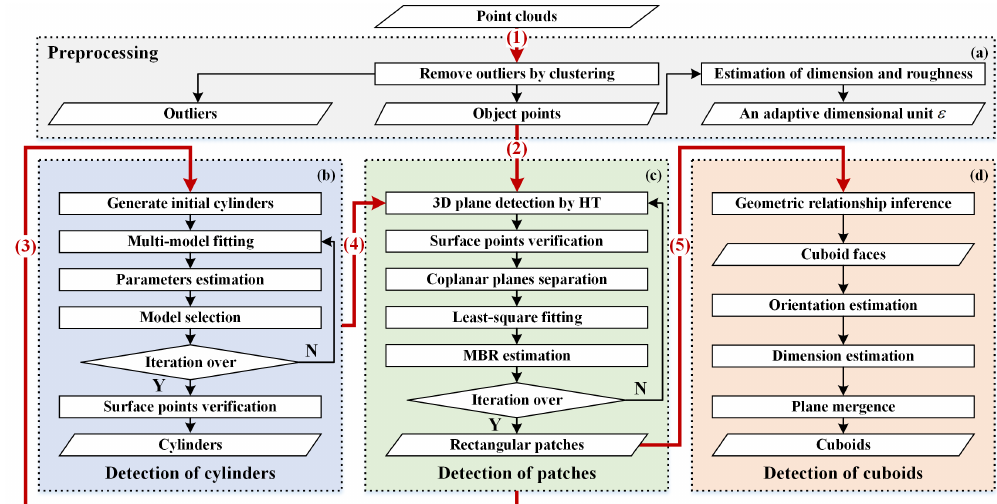
Figure 1. Procedure of the proposed spacecraft component detection scheme. The scheme consists of four modules: ( a ) preprocessing; ( b ) detection of cylinders; ( c ) detection of planar patches and ( d ) detection of cuboids. The scheme is implemented in the order from (1) to (5). Note that the flow lines starting with the borders of module blocks indicate that the remaining points are taken as input. HT, Hough transform; MBR, minimum bounding